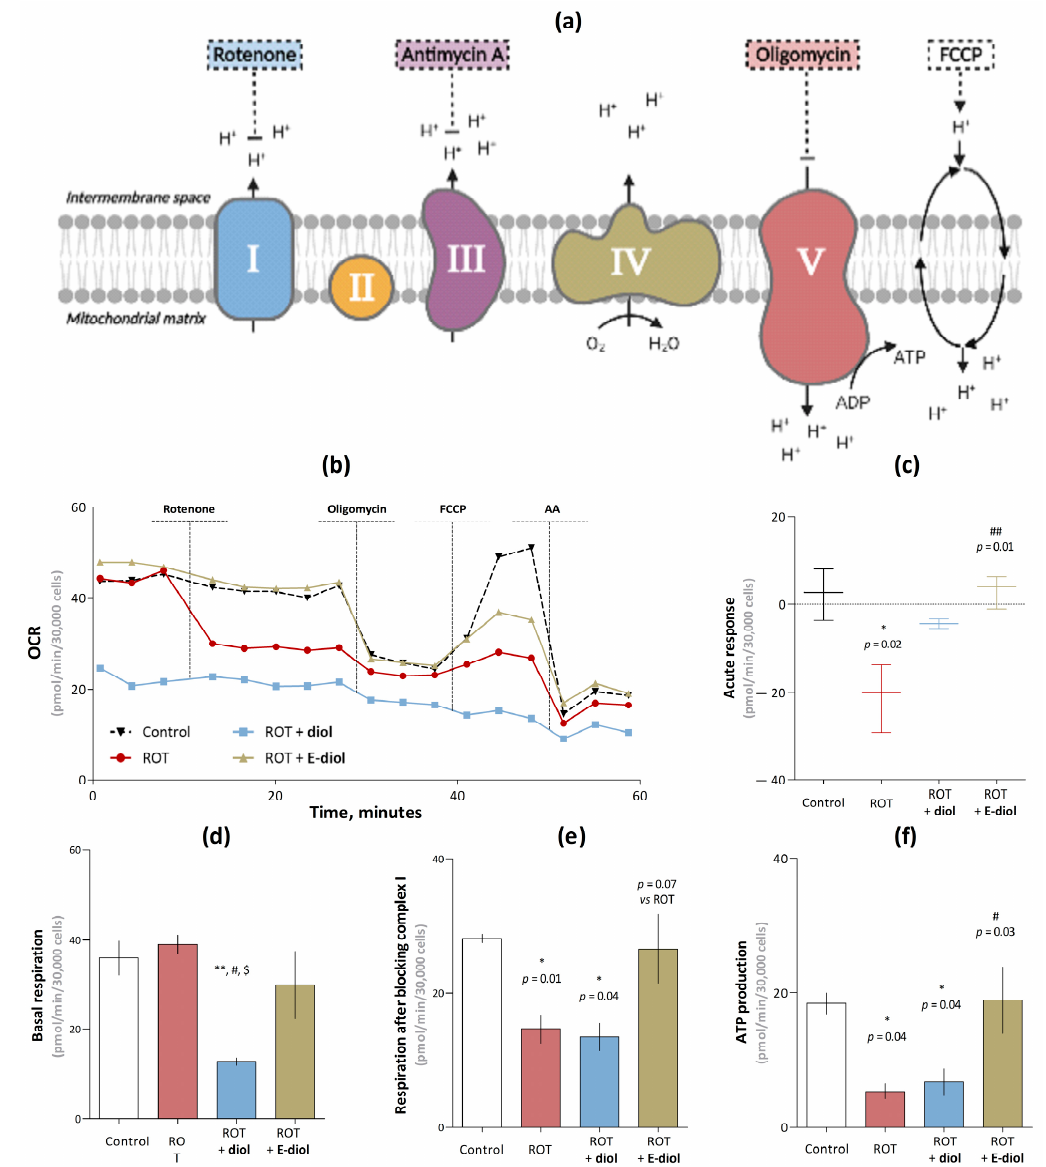
Figure 5. Assessment of respiratory profile and mitochondrial bioenergetic characteristics of neuroblas- toma cell culture SH-SY5Y using Seahorse XF96 Extracellular Flux Analyzer. Schematic repre- sentation of the mitochondrial respiratory chain complexes work and the impact of the Sea- horse/Agilent Mito Stress Test modulators ( a ). Kinetic curves of changes in the oxygen consumption rate of the SH-SY5Y neuroblastoma cell culture (30,000 cells per well) pretreated within 24 h by the studied compounds over time under the modulators action ( b ). The concentrations of diol and epox- idiol were 100 µM, rotenone—10 nM, oligomycin—2 µM, FCCP—2 µM and antimycin A—1 µM. Data are shown as mean ± SEM. Bioenergetic parameters of mitochondria, such as acute response to the fi rst injection of rotenone ( c ); basal respiration, which is the oxygen consumption rate before